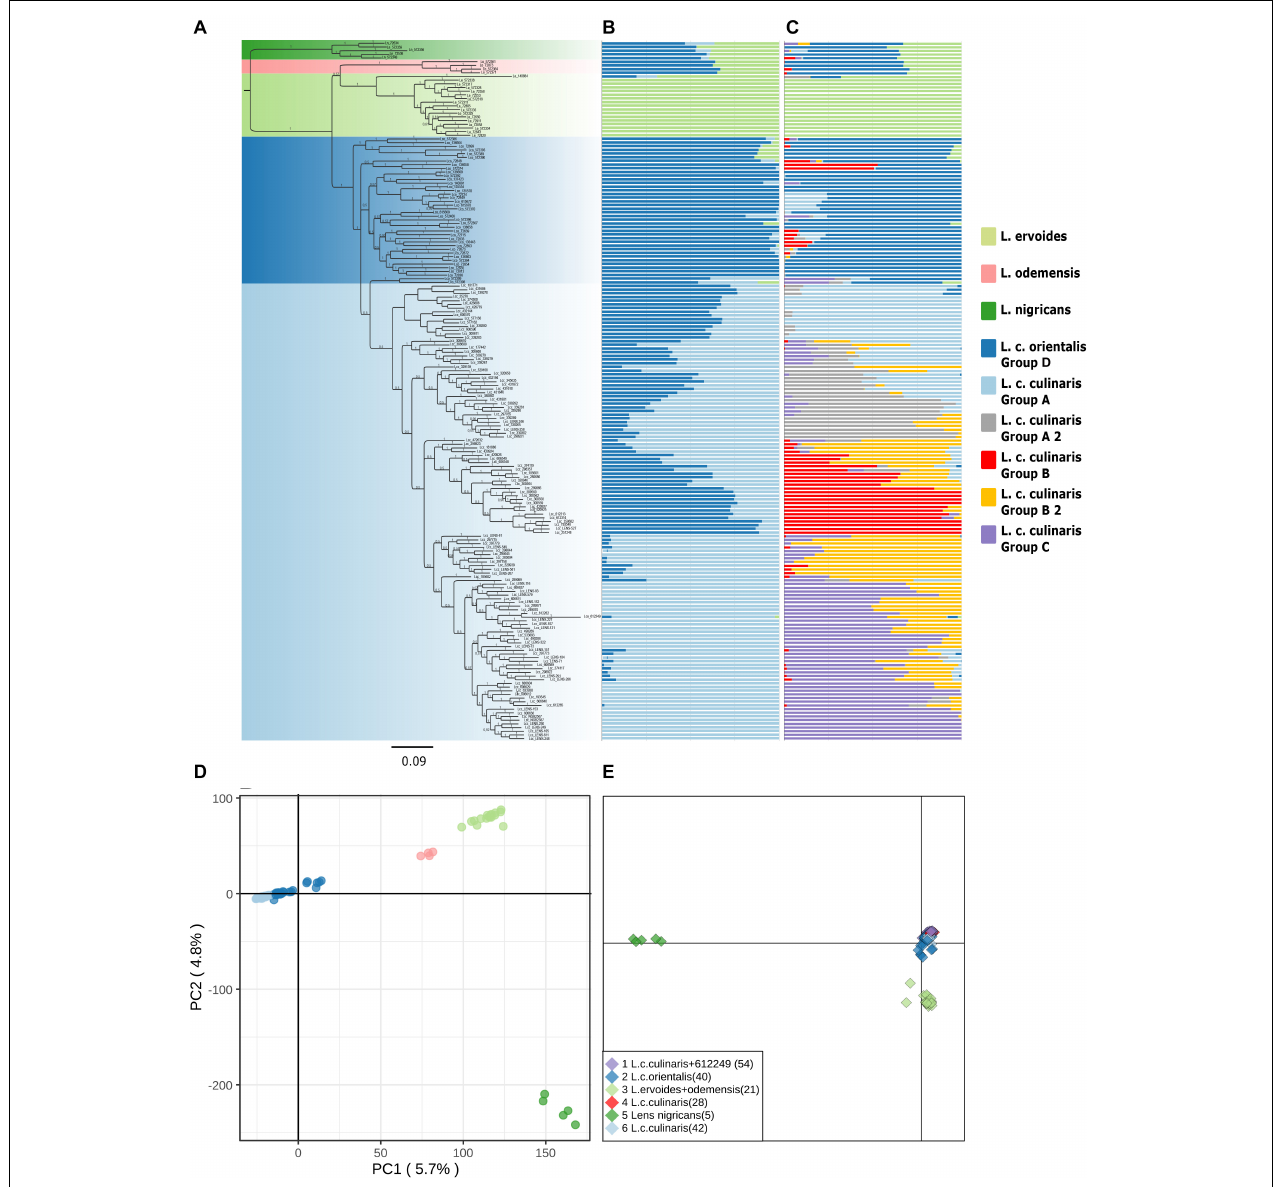
FIGURE 1 | Phylogeny and population structure analysis of 190 accessions of wild and cultivated lentil based on 87,647 SNPs revealed by GBS. (A) MrBayes generated phylogeny. (B) STRUCTURE K = 3 model. (C) STRUCTURE K = 7 model. (D) First and second principal components of a PCA. (E) DAPC